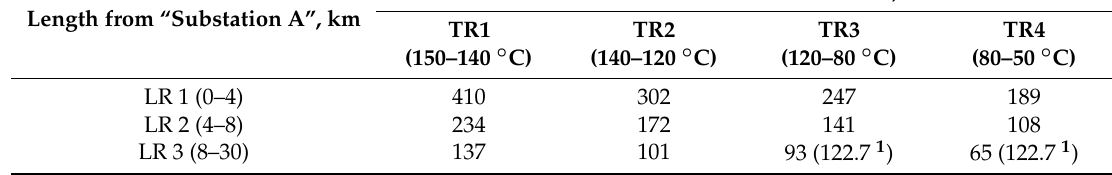
Table 6. Final selection of cross-sectional area of conductor for “OHL No.1”. TR—temperature region; LR—length region.